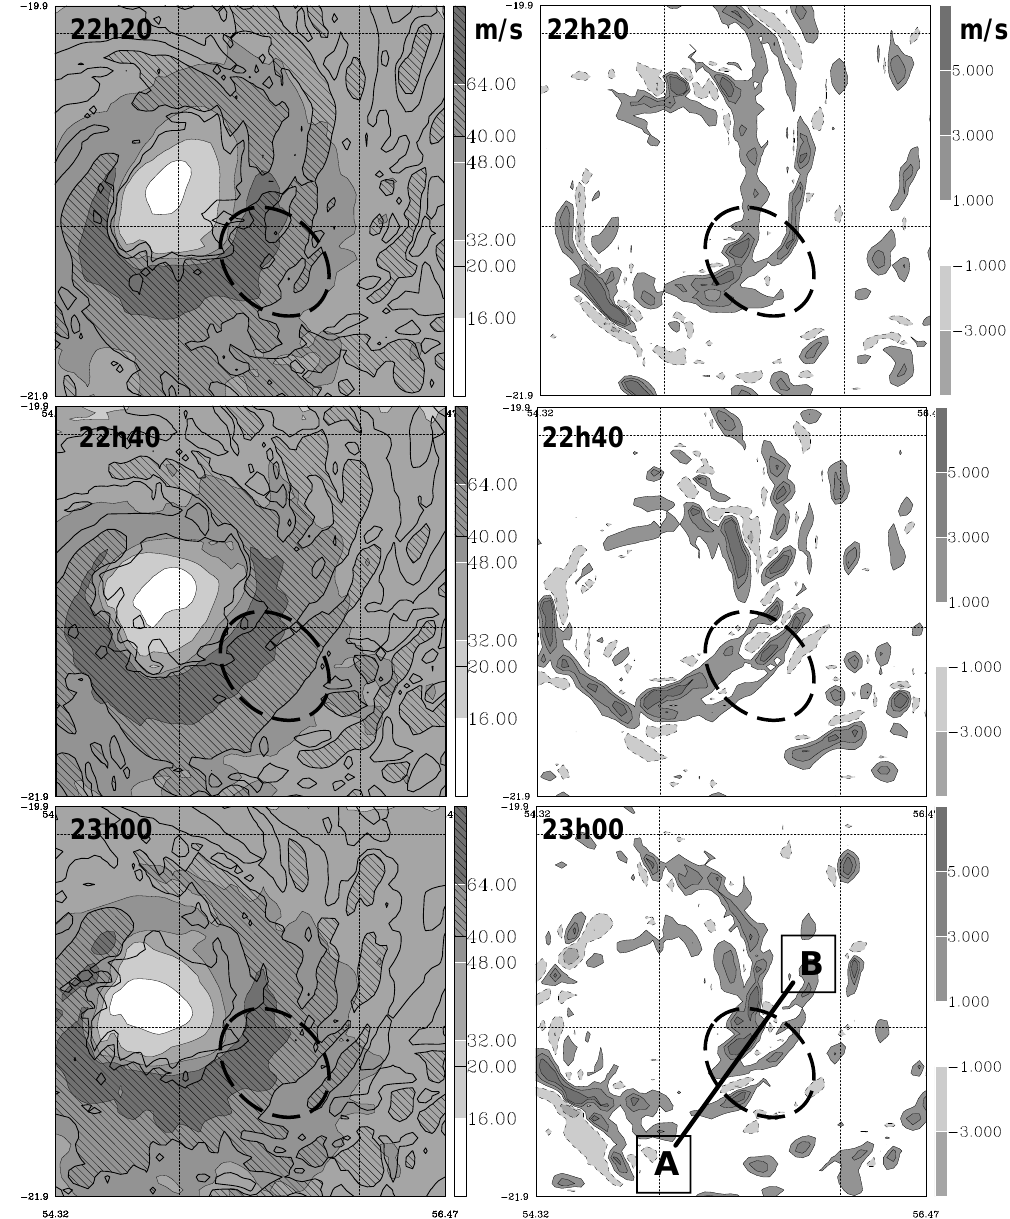
Fig. 9. As in Fig. 8, except for 22:20 to 23h. Line AB in the lower right panel shows the location of the southwest–northeast vertical cross-section in Fig.